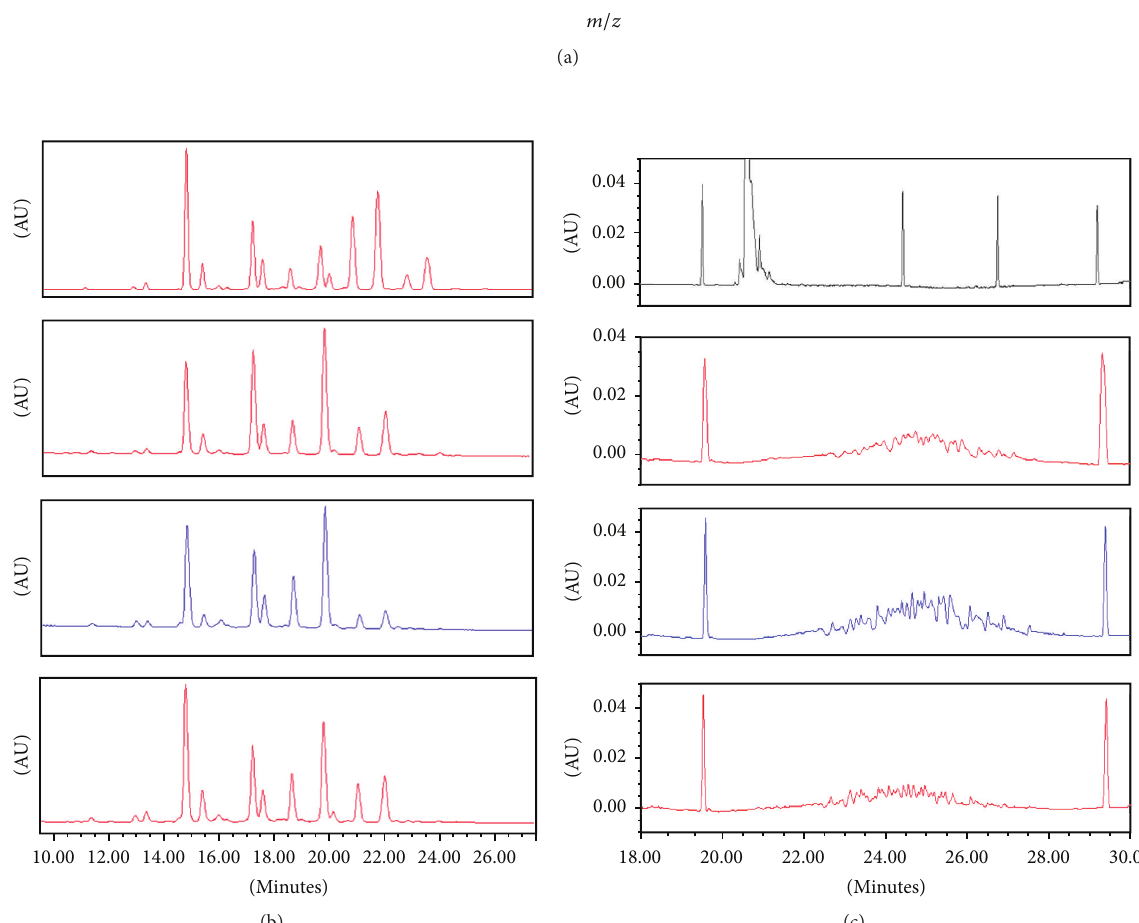
Figure 3: Heterogeneity analyses. (a) MS ( 𝑚/𝑧 ) analyses of etanercept (red) and rituximab (black), (b) glycan heterogeneity by HILI-UPLC of Infinitam (blue) and the reference product (red), and (c) charge heterogeneity by cIEF of Infinitam (blue), reference product (red), and rituximab